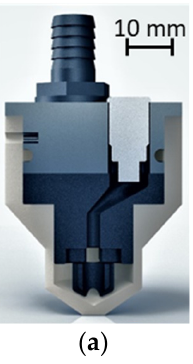
Figure 13. Construction process and chassis parts for the probe developed for the inspection of the pipe weld bead at high temperatures . ( a ) probe assembly cut-out in CAD; ( b ) the lid with the sealing O-ring and connectors for cooling and signaling; ( c ) the FDM-printed sealing O-ring and connectors for cooling and signaling; ( c ) the FDM-printed support used to hold support used to hold the orthogonal coils; ( d ) the final external aspect of the probe. the orthogonal coils; ( d ) the final external aspect of the